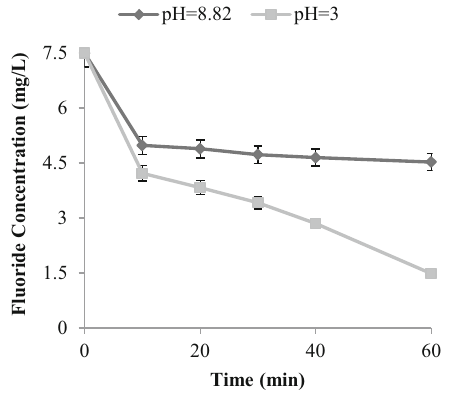
Fig. 10 Removal of fluoride from groundwater collected from Bankura district at different